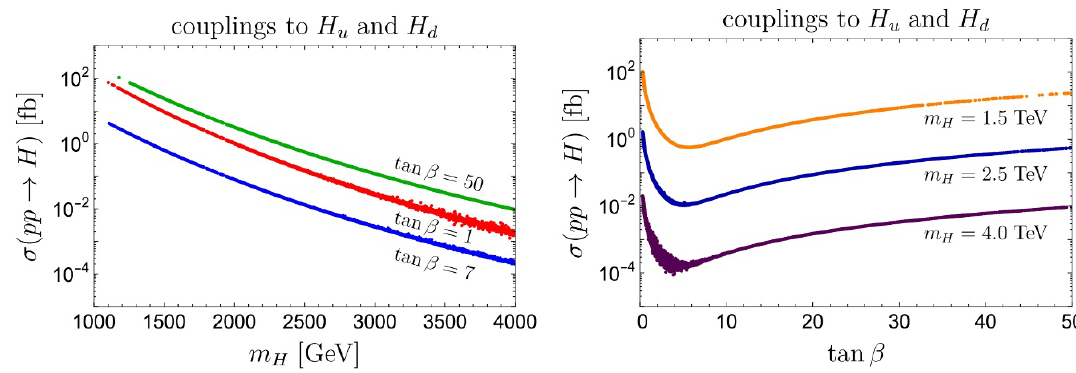
Figure 2 . Production cross section of a heavy neutral Higgs boson in scenarios in which decays through a vectorlike quark are open as a function of m H for tan (cid:12) = 1 ; 7 and 50 (left) and as a function of tan (cid:12) for m H = 1 : 5 ; 2 : 5 and 4 TeV (right). tan (cid:12) dependence of the heavy Higgs couplings to t and t : (cid:21) H / 1 = tan (cid:12) and (cid:21) H / cos (cid:12) , 4 tt t 4 t and couplings to b and b : (cid:21) H / tan (cid:12) and (cid:21) H / sin (cid:12) (see table 2 of ref. [1]). These tan 4 bb b 4 b